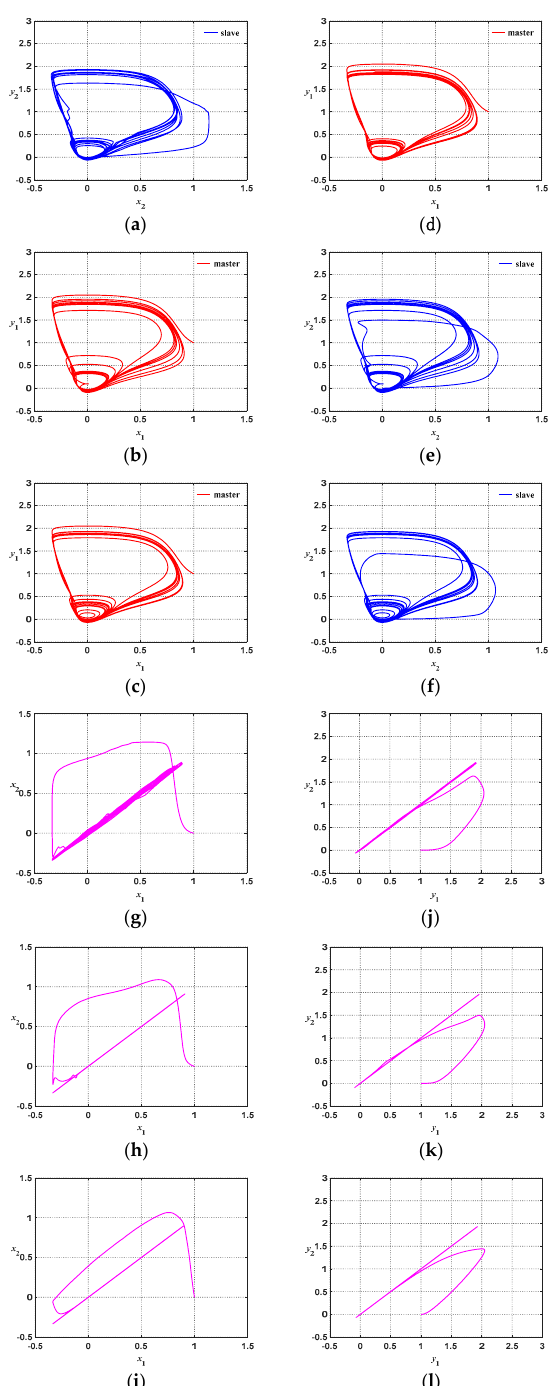
Figure 14. Simulation results of ATFSORC chaotic system synchronization control ( g = 0.01, Cut-in control at 300 sec): ( a ) x 1 , x 2 response for ATFSORC; ( b ) error e x for ATFSORC; ( c ) y 1 , y 2 response diagram for ATFSORC; ( d ) Error e y for ATFSORC; ( e ) Number of association memory layers for ATFSORC; ( f ) Number of association memory layers for ATFSORC (partial); ( g ) Control amount for ATFSORC.